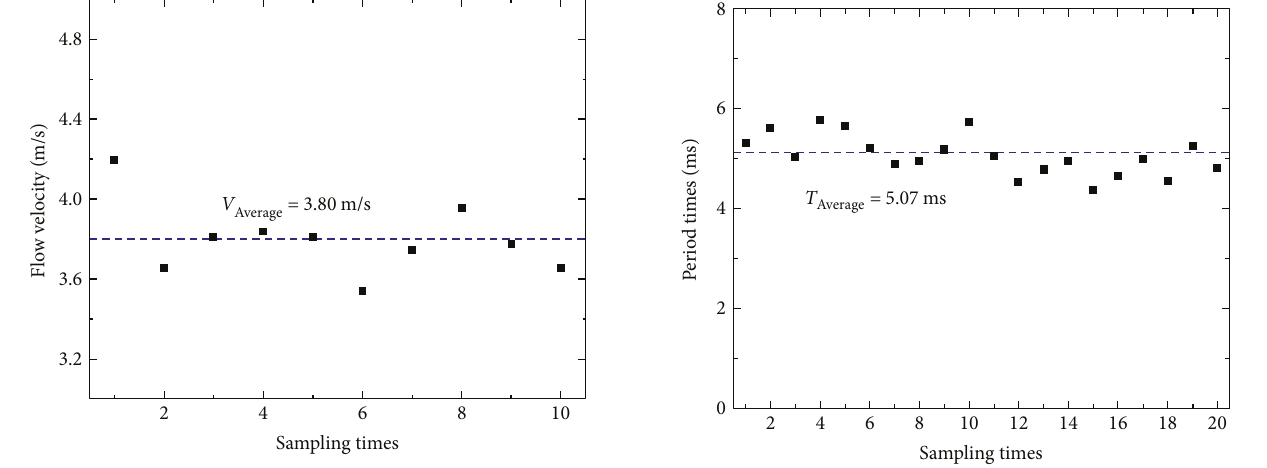
Figure 8: The period of the wake fl ow in the sample. Reynolds number =800, the diameter =2mm, the sheet position =3 mm, and the distance between the cylinder and the slot was 5.9cm. The jet direction was at an angle of 45 ° to the surface of the fl